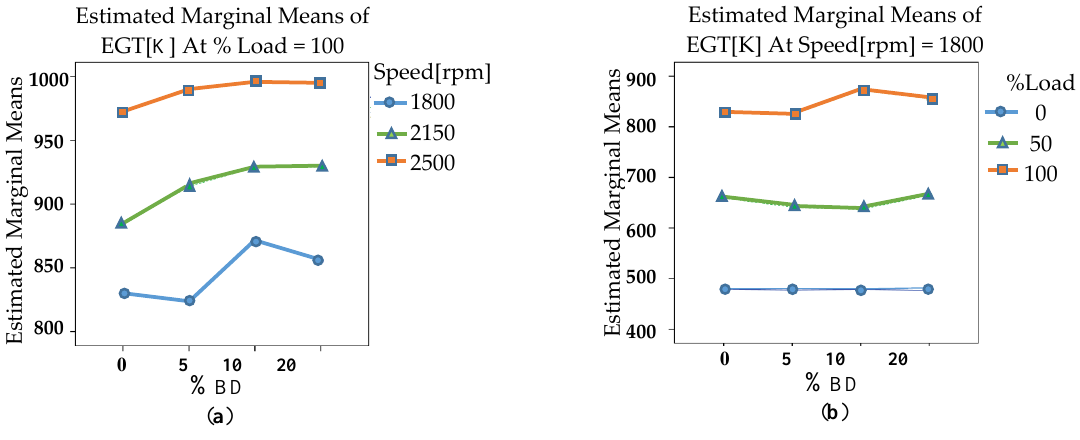
Figure 5. EGT changes at constant load ( a ) and engine speed ( b ).